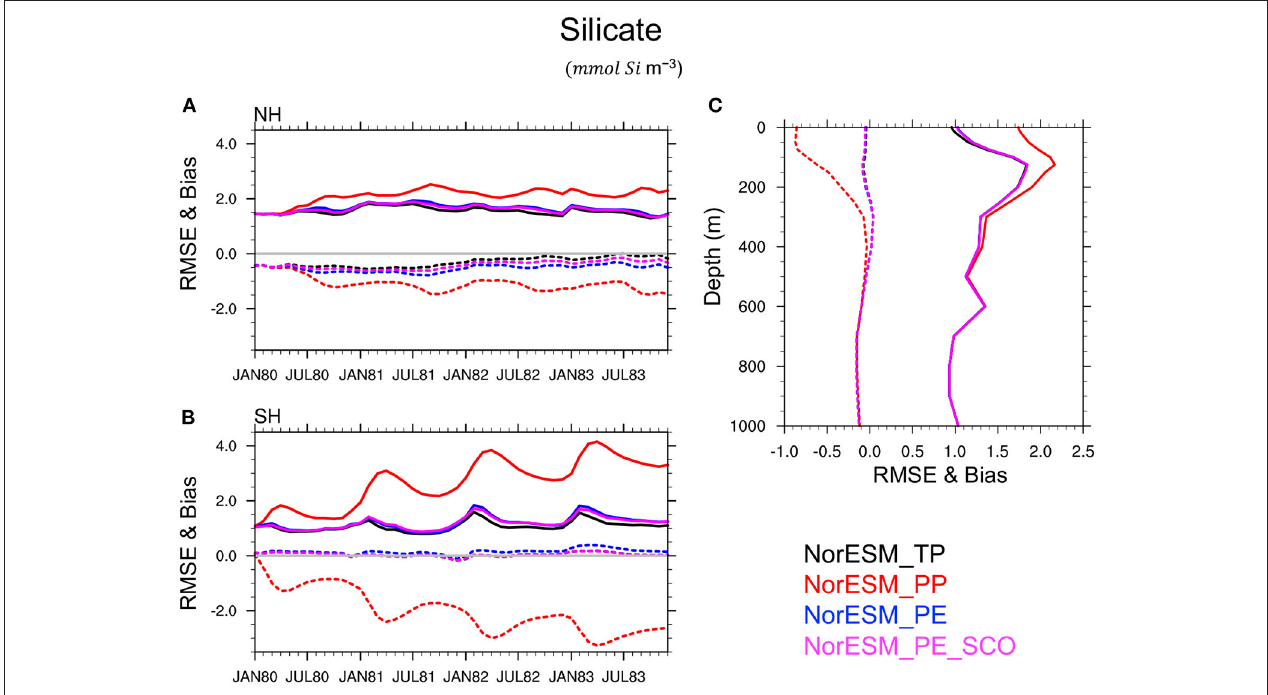
FIGURE 8 | Same as Figure 7 but for Silicate.